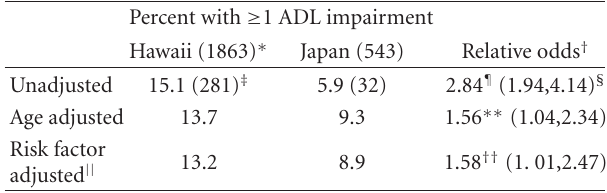
Table 4: Unadjusted and adjusted percent of elderly men with ≥ 1 impairment in activities of daily living (ADL) in Hawaii and